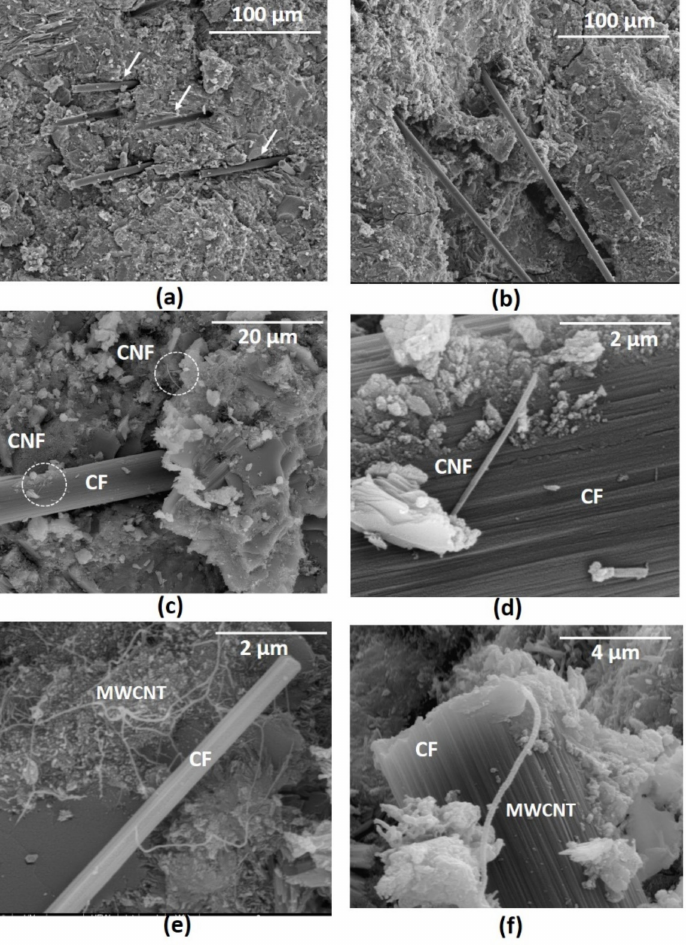
Figure 19. Fracture surface of a plain mortar ( a , b ), cementitious composite with CNFs ( c , d ) and a cementitious composite with MWCNTs ( e , f ) at different